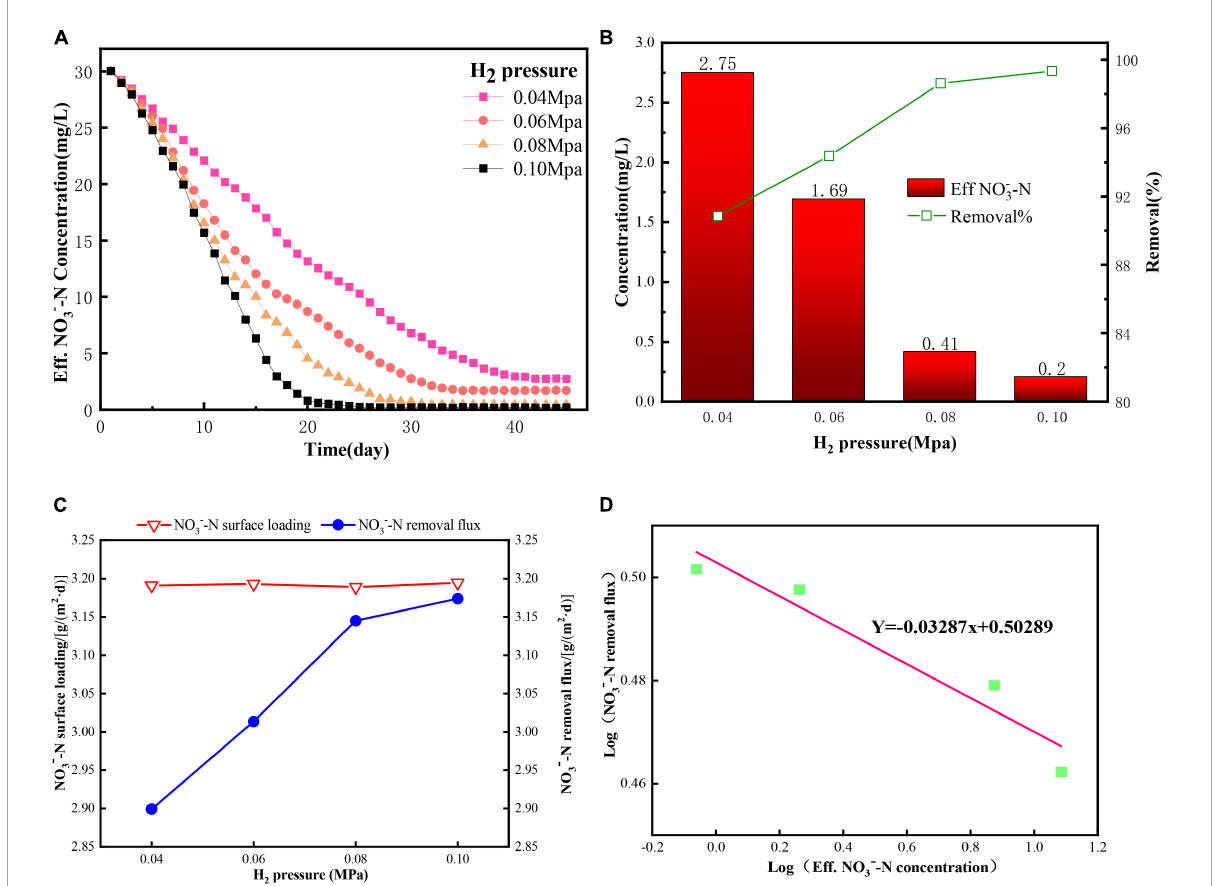
FIGURE4 The effect of H 2 supply pressure on the denitrification performance of the H 2 -based MBfR: (A) The NO 3 - –N concentrations in the effluent from the replacement of the bulk liquid with 30 mg N/L, (B) Effluent concentrations and removal percentages of NO 3 - –N under steady states, (C) Surface loading and removal flux, and (D) Reaction order of NO 3 - –N removal under the four H 2 supply pressures of 0.04, 0.06, 0.08, and 0.1 MPa operating in the four